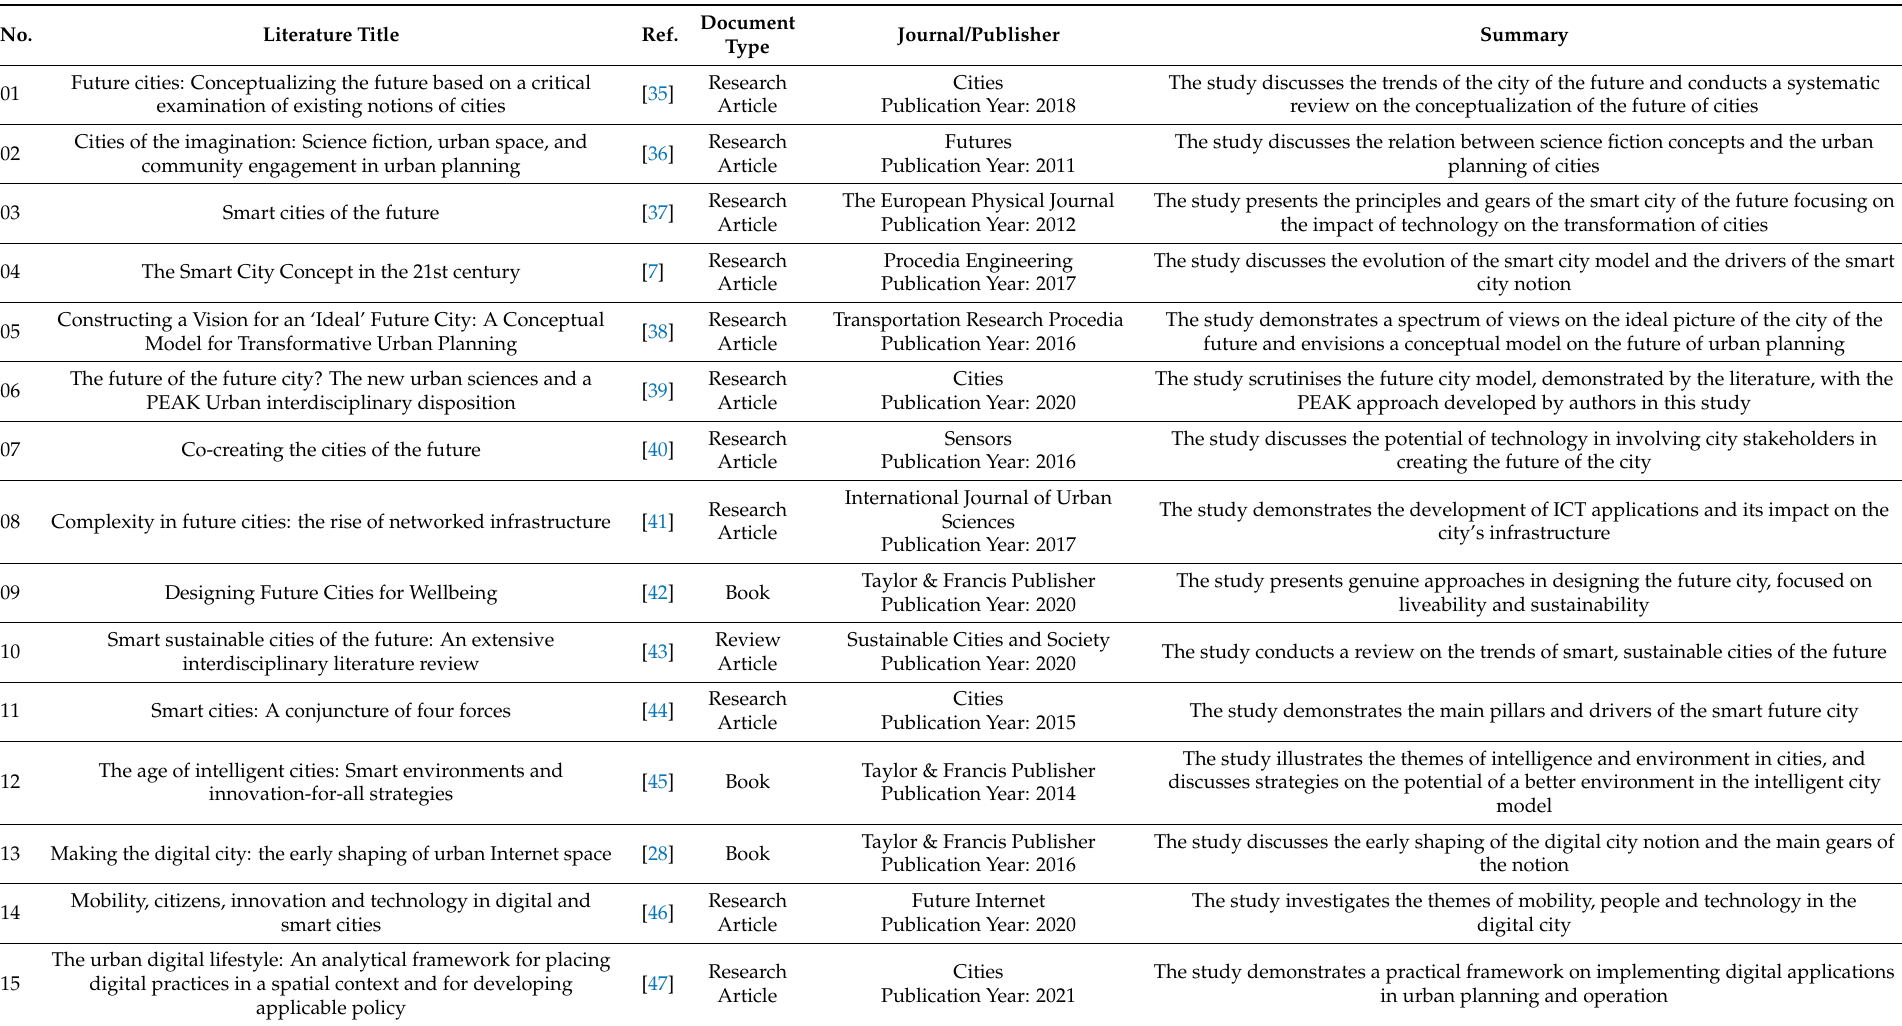
Table 3. Nominated literature of the systematic